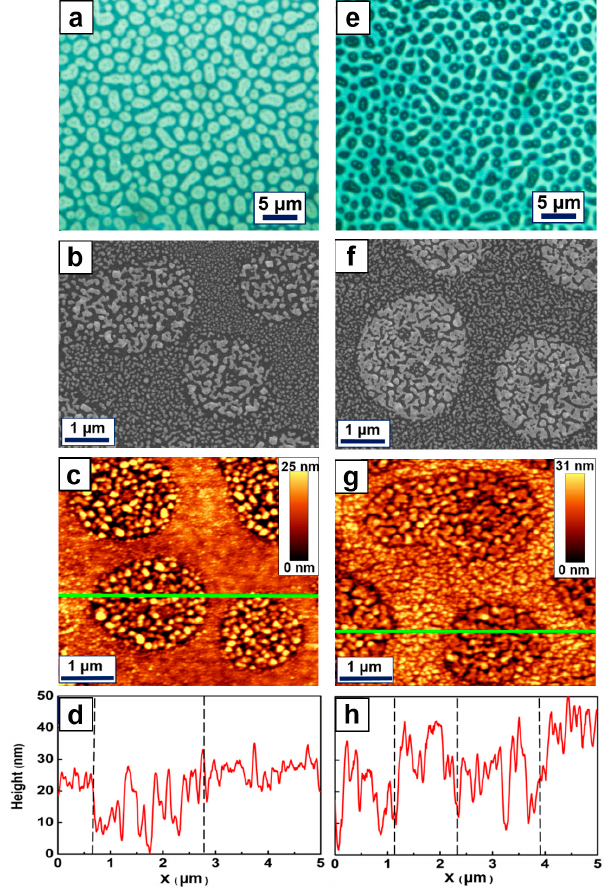
Figure 3. ( a – d ): Optical microscopic, scanning electron microscopic (SEM), atomic force microscopic (AFM), and AFM height profile images of Sample A, respectively; ( e – h ): Optical microscopic, SEM, AFM, and AFM height profile images of Sample B, respectively. The optical microscopic images in ( a , e ) have been taken before the annealing process for Samples A and B, respectively.